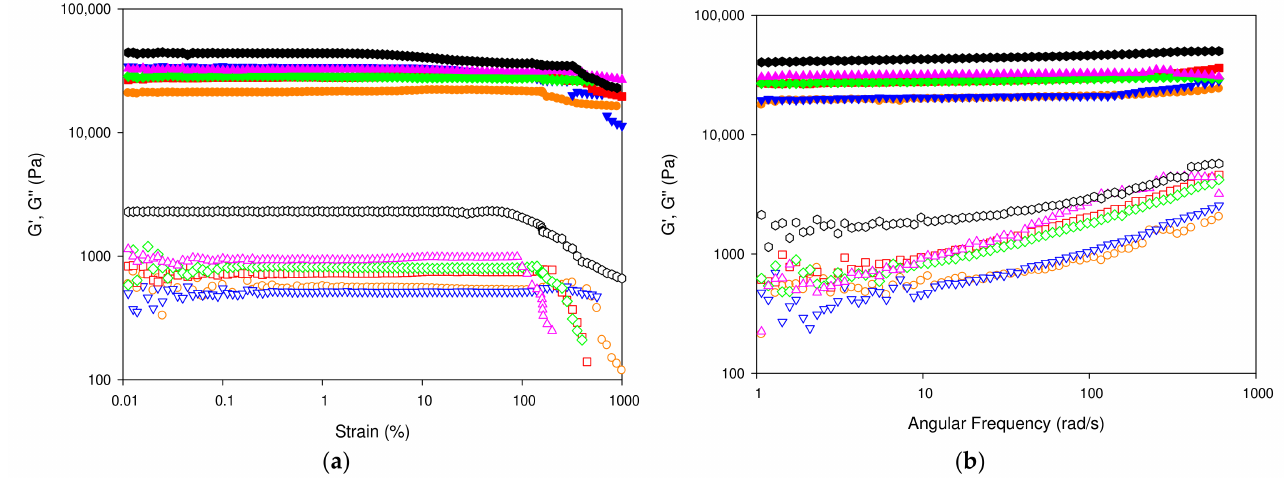
Figure 4. ( a ) Shear rate–shear viscosity flow curves and; ( b ) strain amplitude sweeps at a fre- Figure 17. Store (G (cid:48) ) and loss (G (cid:48)(cid:48) ) moduli ( a ) versus strain; ( b ) versus angular frequency for: GE and quency of 0.05 Hz obtained for water, IL and IL/Water emulsions at 10 °C (  ) Water, (  ) 1IL/Wa- ter, (  ) 5IL/Water, (  ) 10IL/Water, (  ) 15IL/Water, (  ) 25IL/Water and (  ) GE/IL hydrogels: ( ) GE, ( ) GE/1IL, ( ) GE/5IL, ( ) GE/10IL, ( ) GE/15IL and (